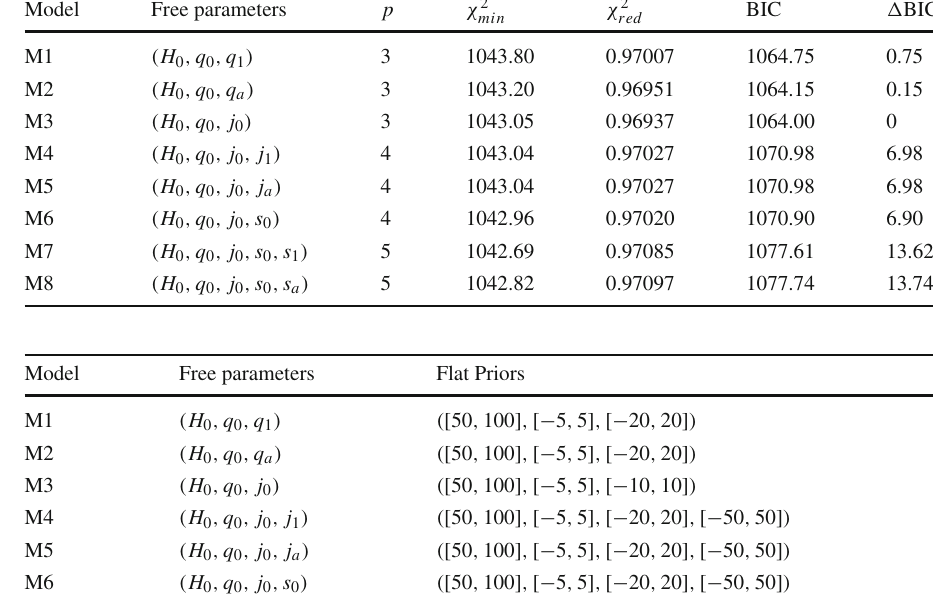
Model Free parameters